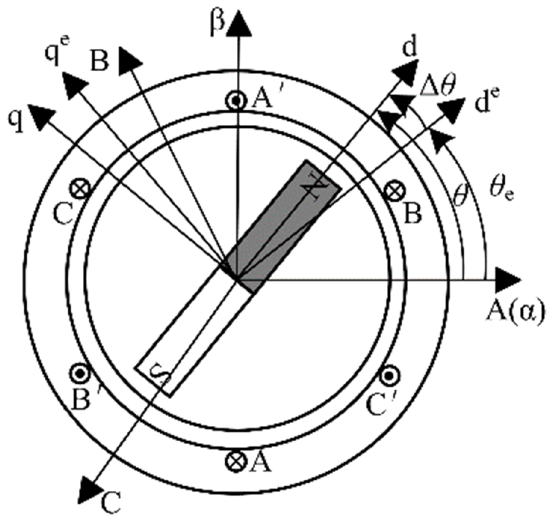
Figure 2. The relationship between different coordinate systems.